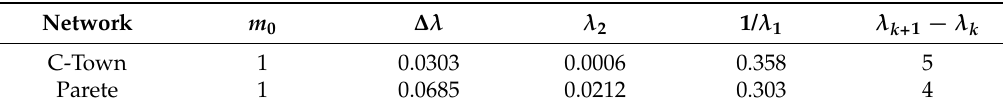
Table 4. Principal Eigenvalues of the Adjacency and Laplacian matrices of water distribution network of C-Town and